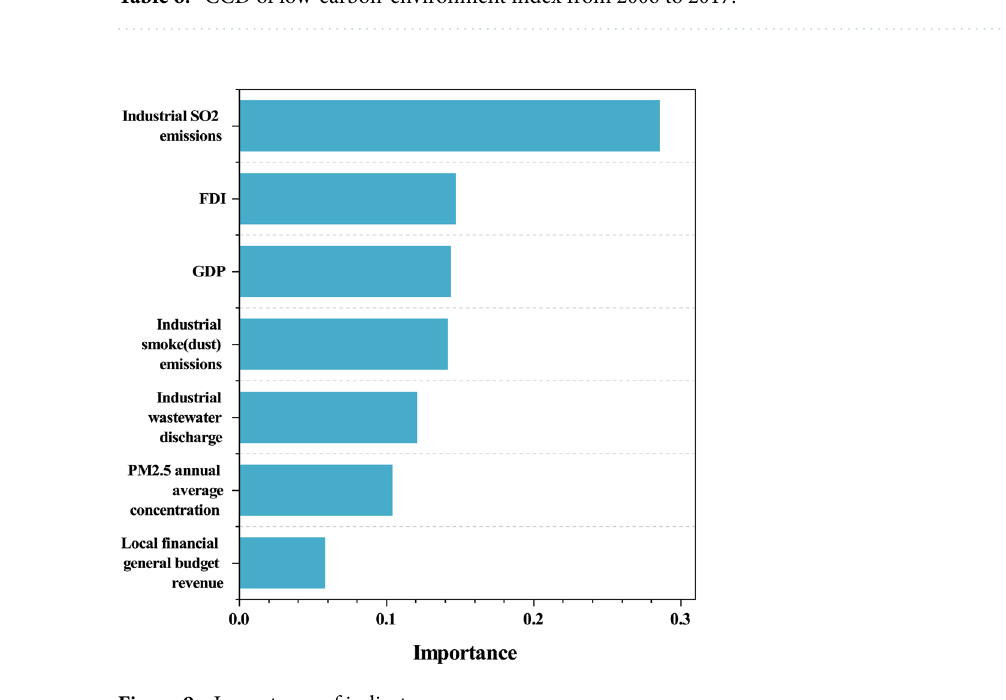
Figure 9. Importance of